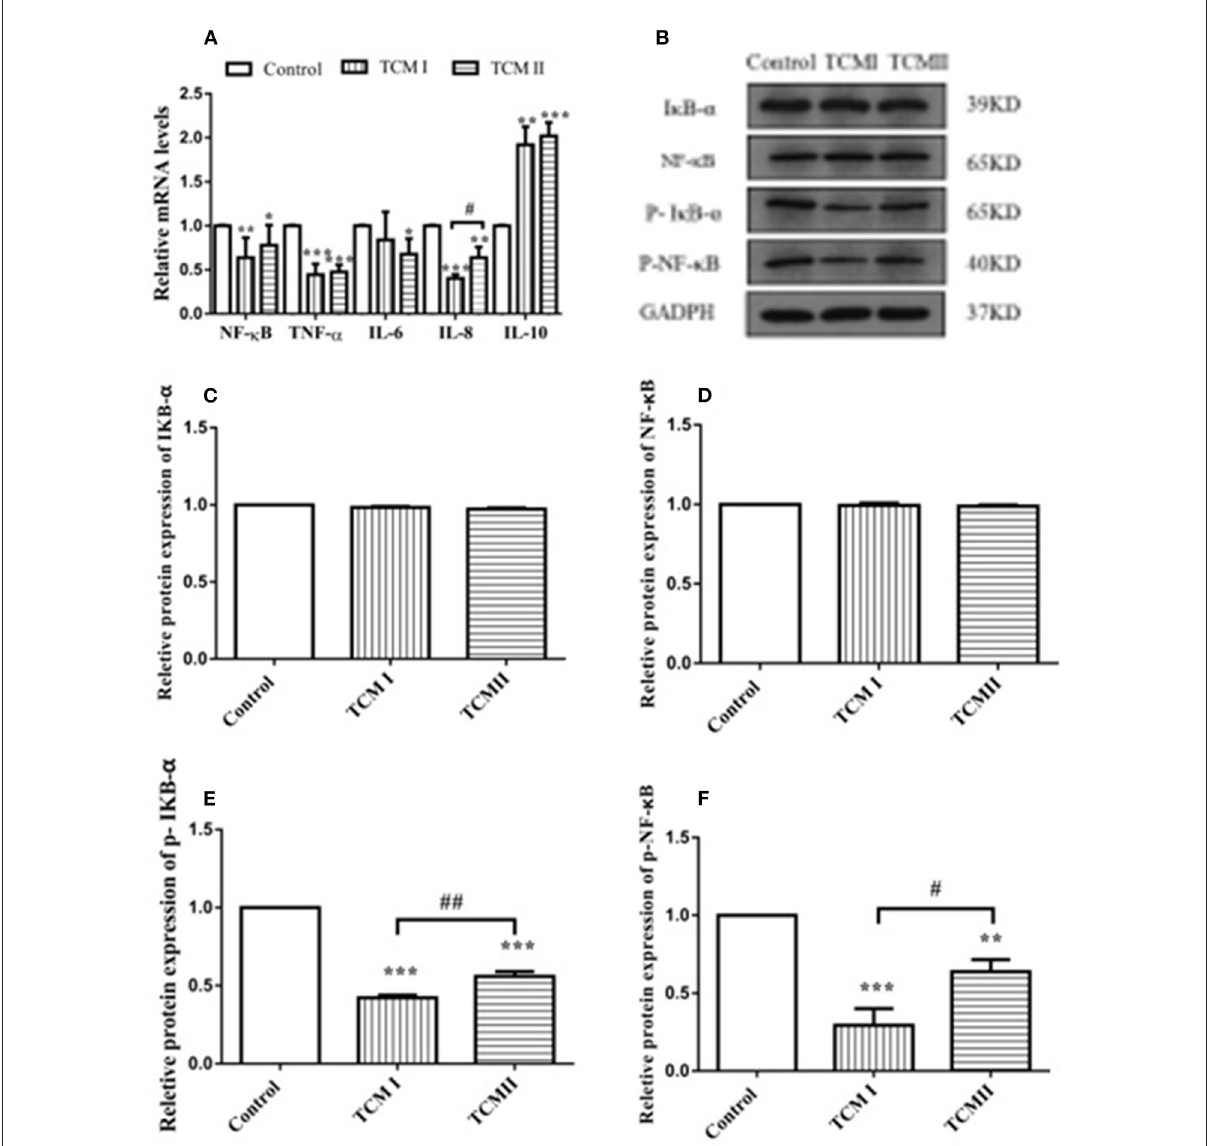
FIGURE4 Effects of TCM I and TCM II on the mRNA levels of inflammatory cytokines and protein levels in liver. (A) mRNA levels of NF- κ B, TNF- α , IL-6, IL-8, and IL-10. (B) Protein levels of I κ B- α , NF- κ B p65, p-I κ B- α , and p-NF- κ B. (C) Graph showing the protein level of I κ B- α . (D) Graph showing the protein level of NF- κ B p65. (E) Graph showing the protein level of p-I κ B- α . (F) Graph showing the protein level of p-NF- κ